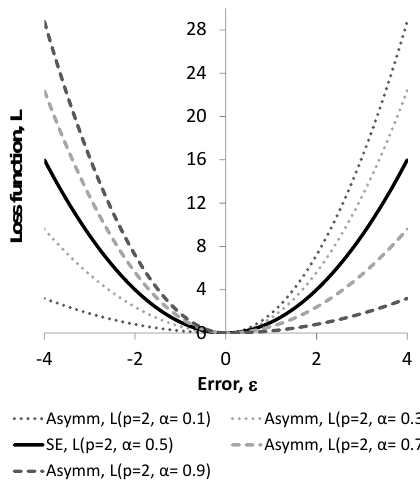
Figure 1. Asymmetric quad–quad loss function (with α varying from 0.1 to 0.9) compared with the squared error